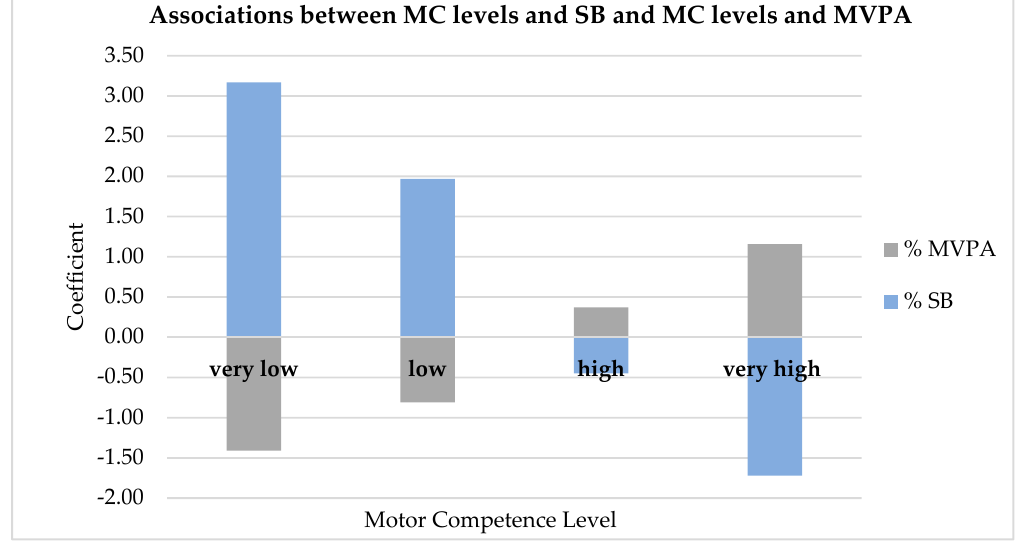
Figure 1. Associations (coefficients) between MC categories (MC1 = very low; MC2 = low; MC4 = high, MC5 = very high. Referent is MC3 = average MC) and % time spent in SB and between MC and % time spent in MVPA.